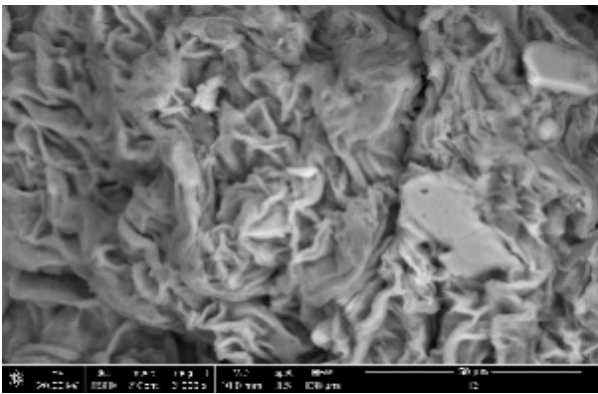
Figure 14. SEM micrograph recorded for sample P1.